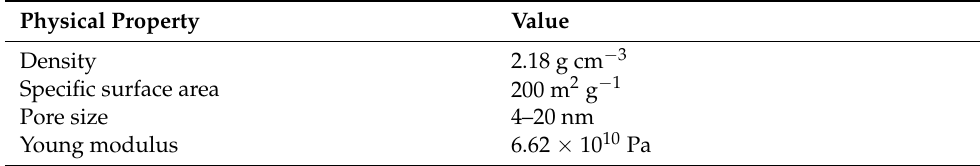
Table 1. Physical characteristics of the Vycor ® porous